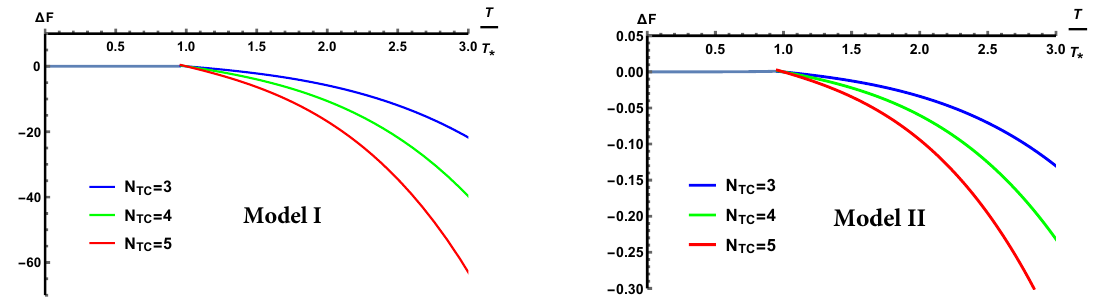
Figure 2 . The free energy di(cid:11)erence for Model-I and Model-II with N TC = 3, N TC = 4 and N TC = 5,